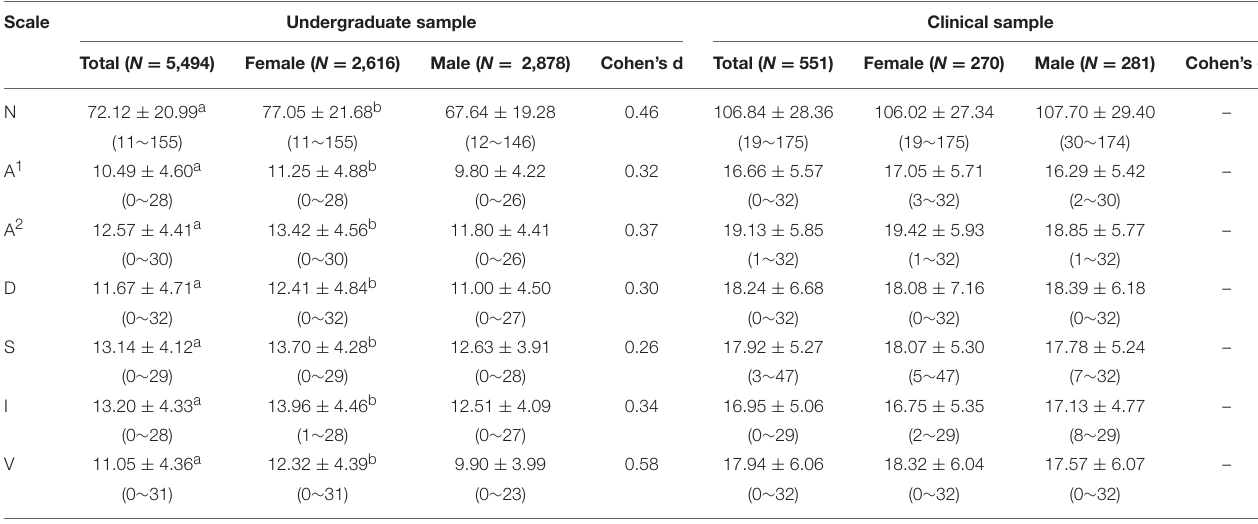
TABLE 6 | Scores on total neuroticism subscale and each of the six facets separated by gender (Means ± SD, ranges).